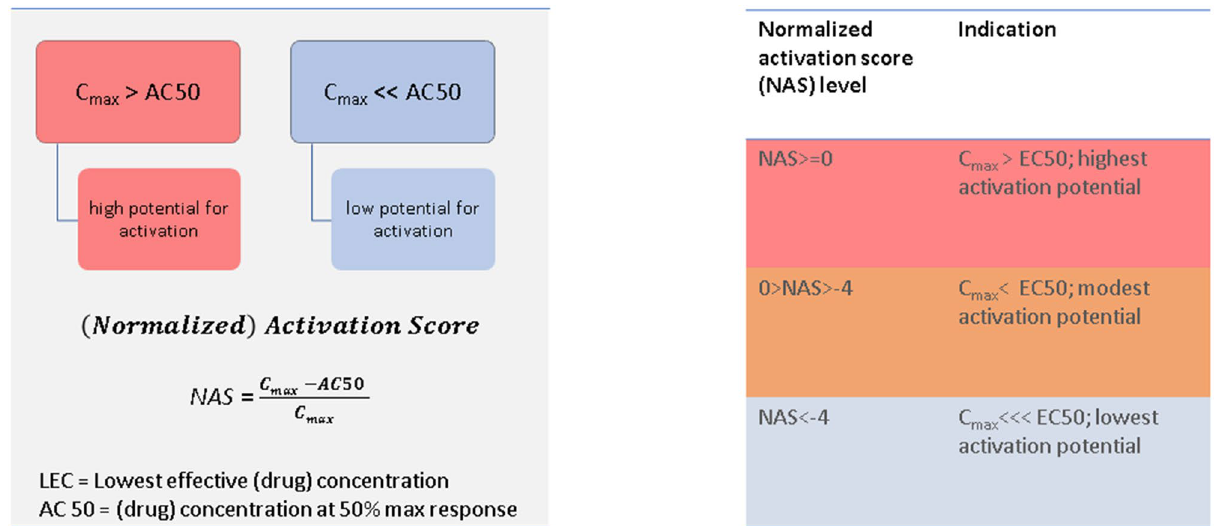
Figure 6. Definitions of Noramlized Activation Score and biological targets activation